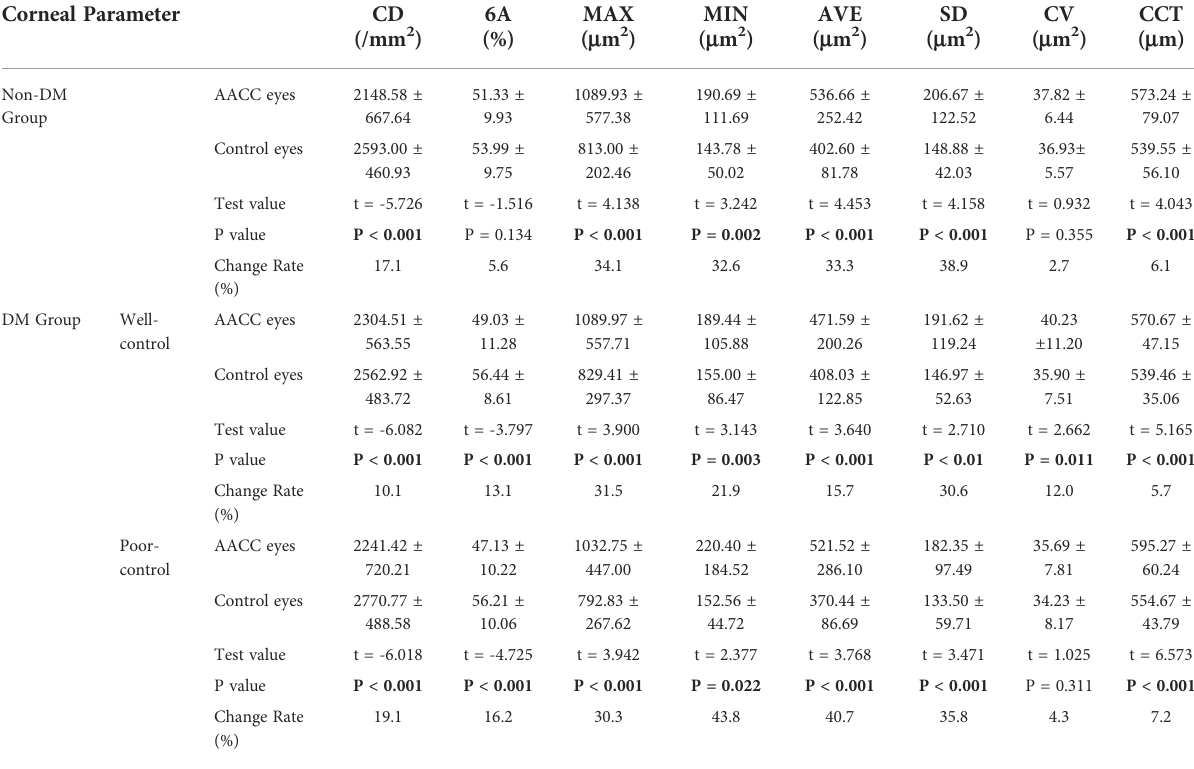
TABLE 2 Corneal parameters of acute angle closure crisis (AACC) eyes and control eyes in study groups. Corneal